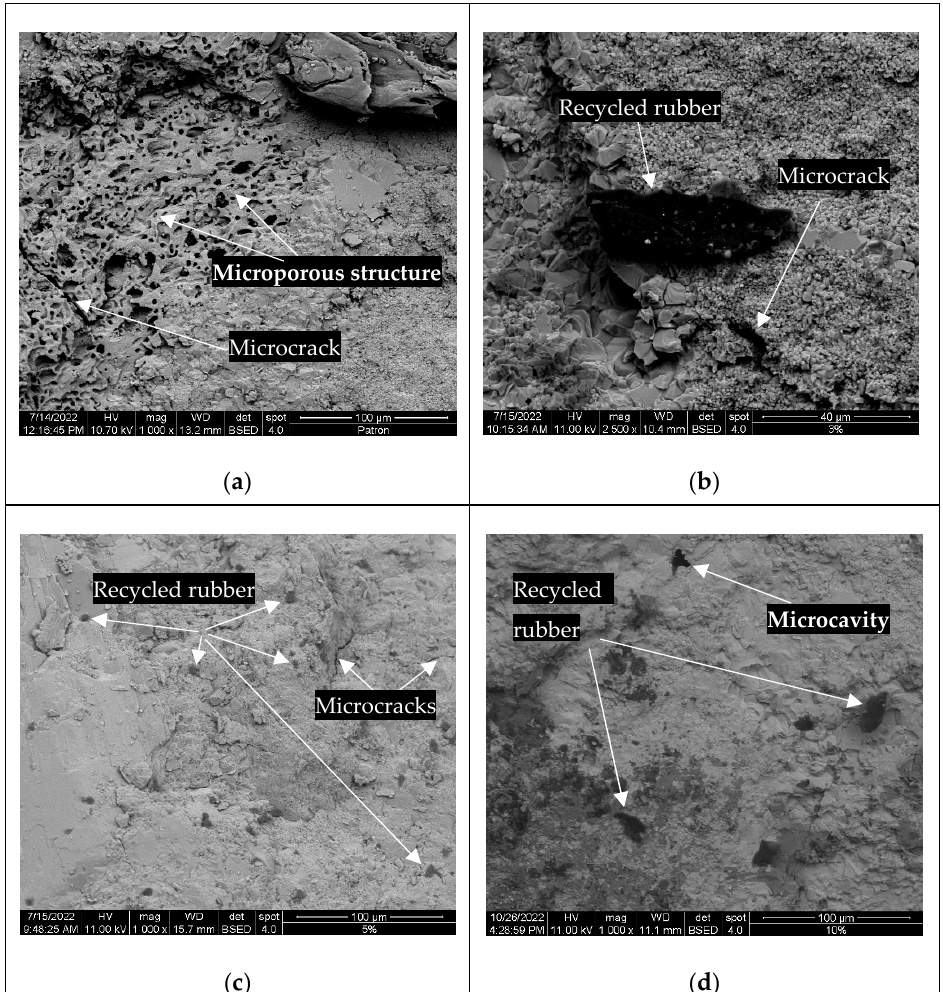
Figure 6. SEM images of concrete mixed with ground rubber particle in different proportions: ( a ) 0%; ( b ) 3%; ( c ) 5%; and ( d ) 10%.